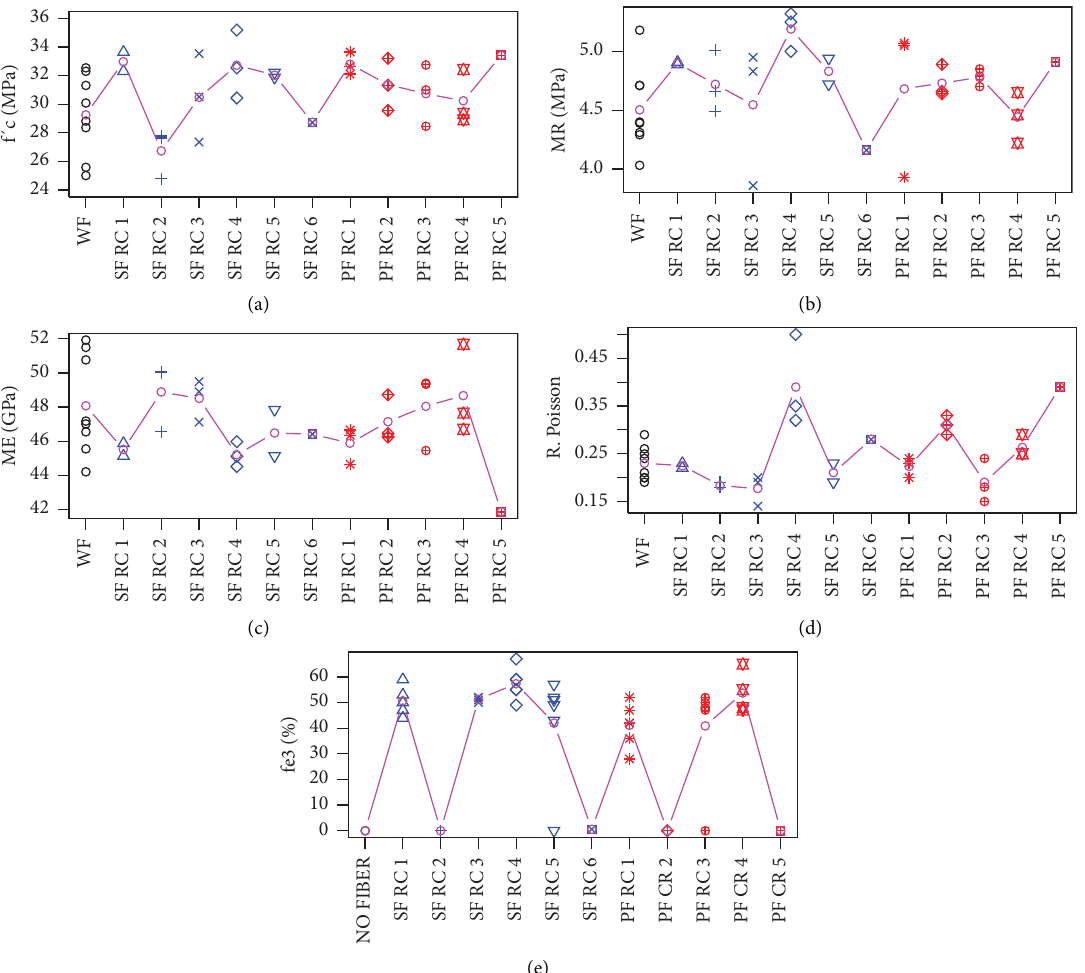
Figure 6: Graph of the results. (a) Compressive strength. (b) Modulus of rupture. (c) Modulus of elasticity. (d) Poisson’s ratio. (e) Residual